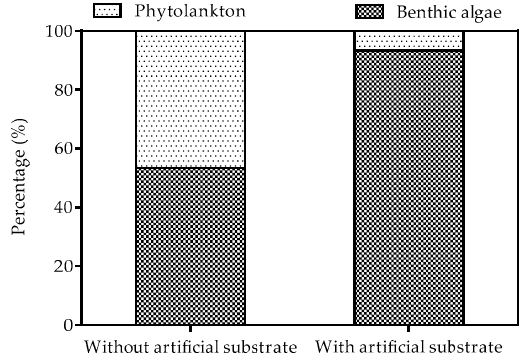
Figure 5. Contribution of phytoplankton and benthic chlorophyll a (Chl- a ) to total biomass in the two treatments by the end of the experiment.